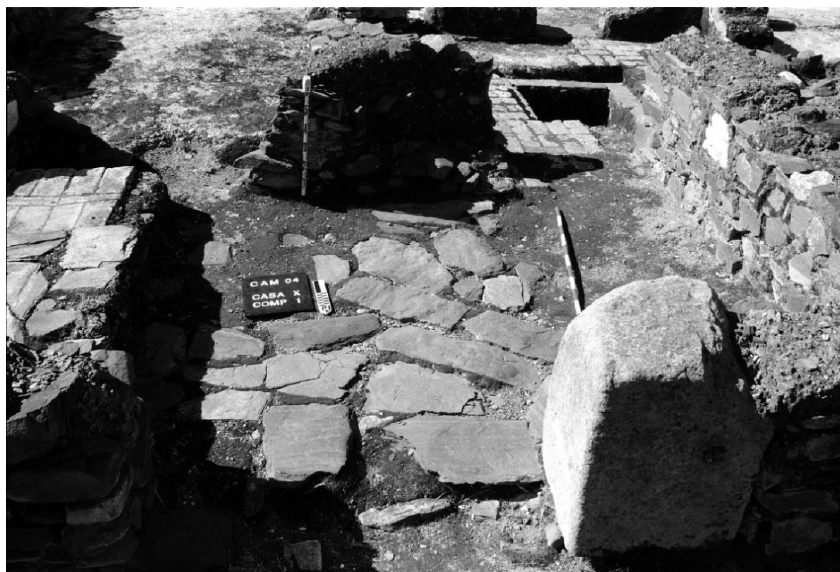
Figure 6. Mértola—house n. 10 (entrance). Photo took by author.